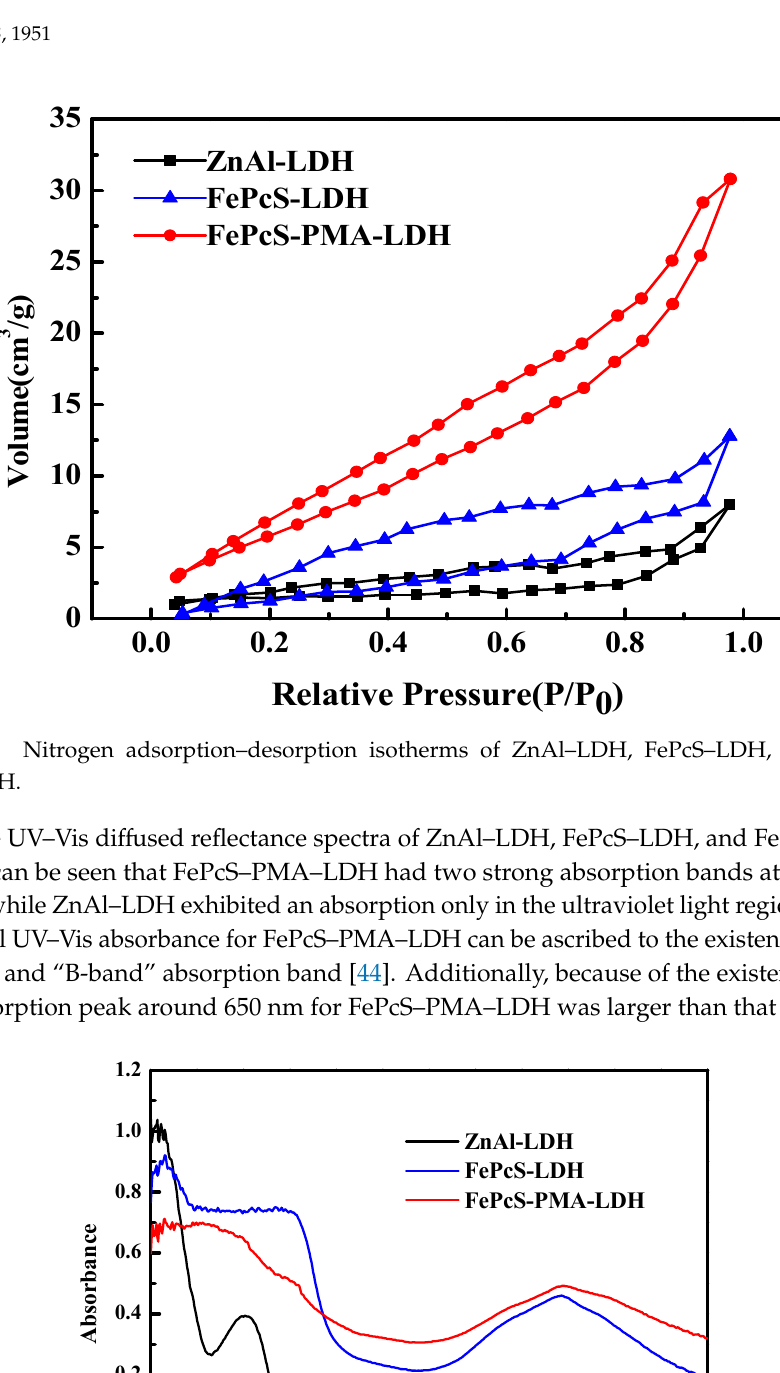
Table 2. Brunauer–Emmett–Teller (BET) surface areas, pore volumes, and pore sizes of ZnAl–LDH, FePcS–LDH, and FePcS–PMA–LDH.